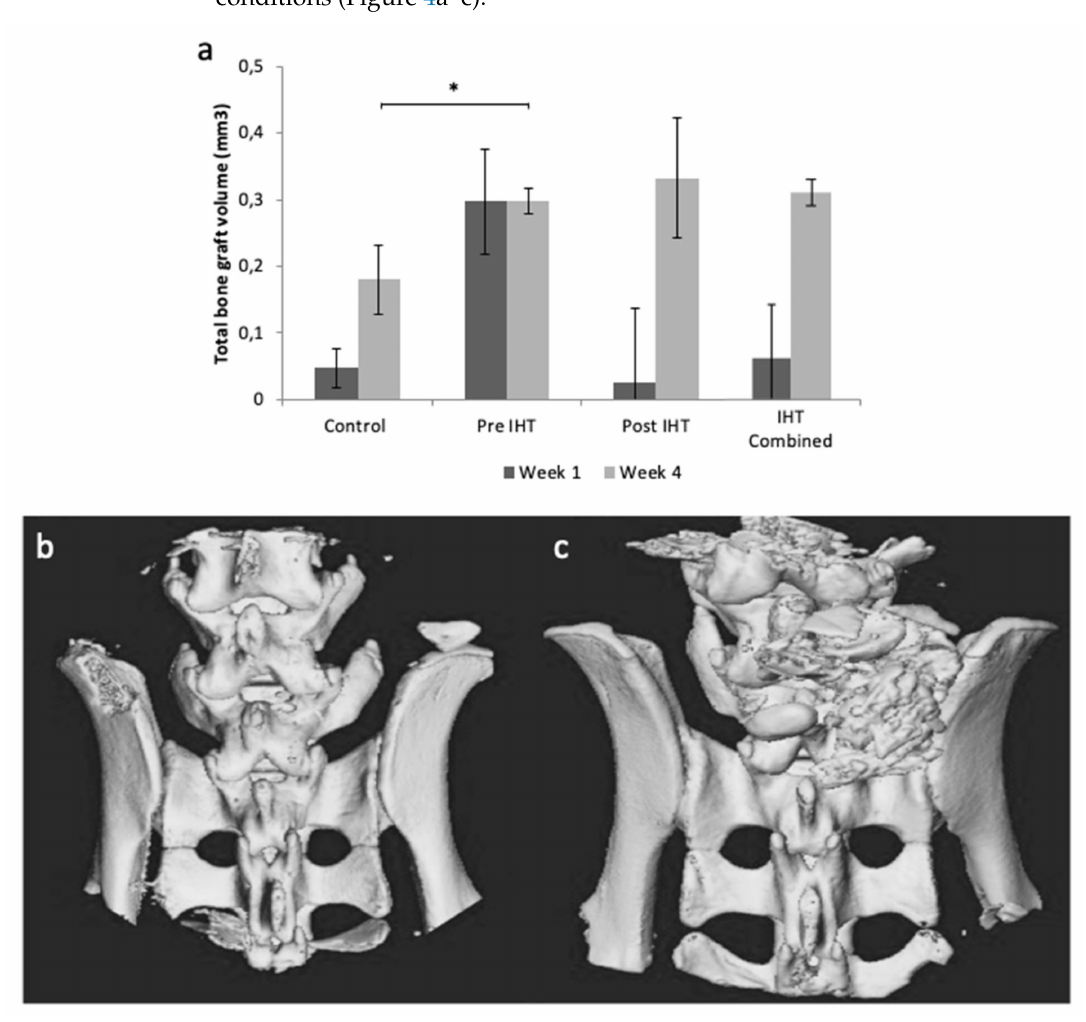
Figure 1. Intermittent Hypoxic Therapy (IHT) reduced bone resorption in vivo. Male C57BL/6 mice 6–10 weeks old receiving implantation of 10 mg allogenic bone graft posterior to the lumbar spine. Total bone-graft volume showed to be holding a prominent position within IHT